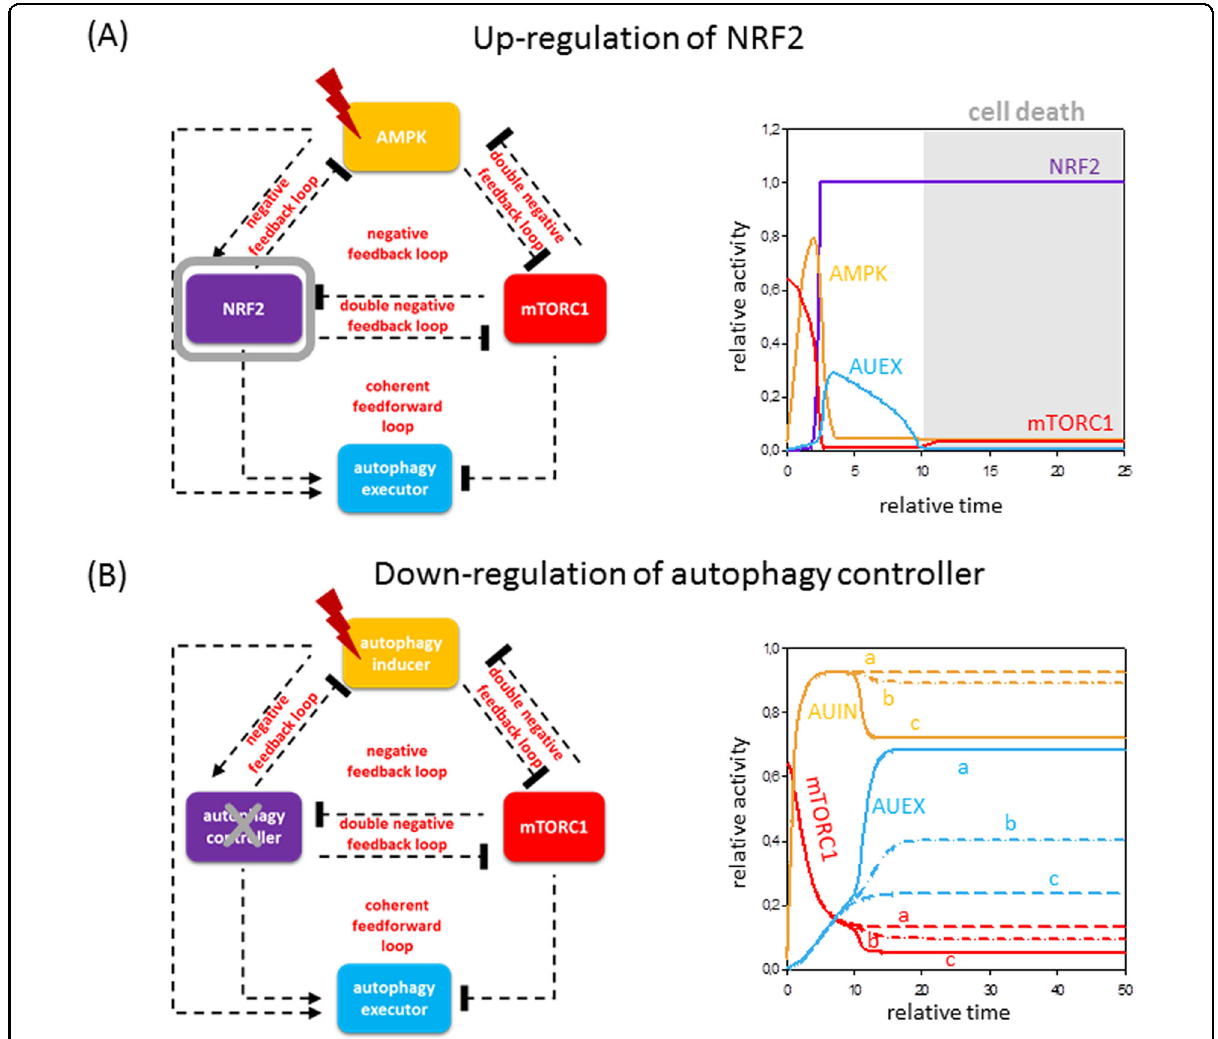
Fig. 5 The precise level of autophagy controller is essential in stress response. Different mutant phenotypes are simulated: A Keap1 depletion (NRF2 activation) is mimicked upon excessive level of cellular stress (stress = 7.5, kaac = 5). B Depletion of autophagy controller is achieved on various levels (stress = 7.5, AUCO-T = 0.01, see lines marked with ‘ a ’ ; stress = 0.03, see lines marked with ‘ b ’ ; stress = 0.05, see lines marked with ‘ c ’ ). Grey background refers to possible cell death. For details about the codes and software used for simulations, see the Supplementary